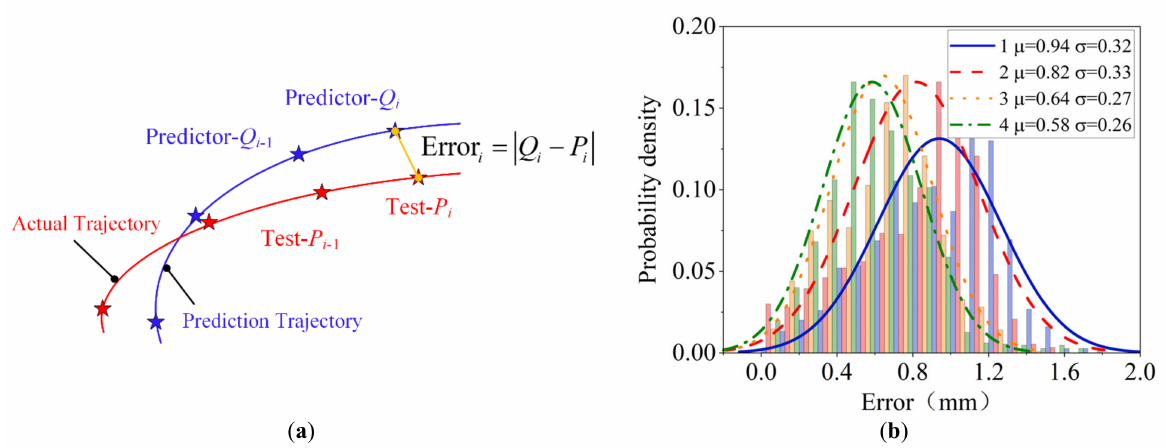
Figure 4. ( a ) Definition of prediction errors. ( b ) Probability density of prediction